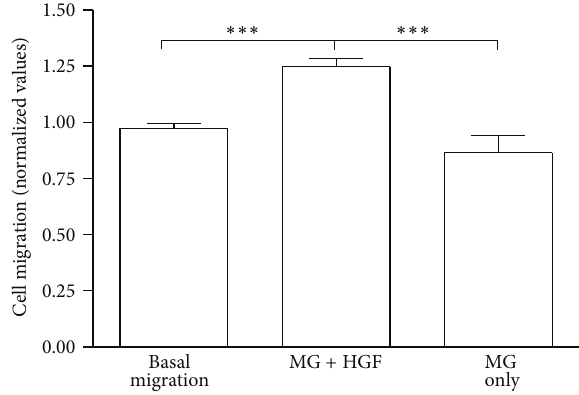
Figure 9: MSC invasion assay with Matrigel ± HGF. MG: Matrigel. All values normalized to basal migration. ∗∗∗ 𝑃 < 0.001 . Results represent 𝑛 = 3